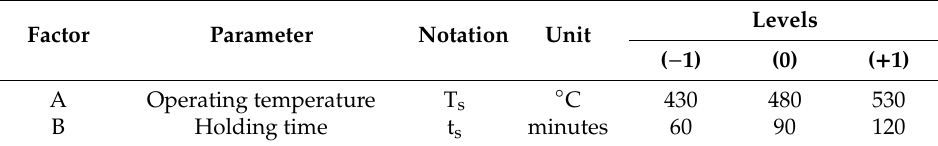
Table 1. Experimental design parameters and levels